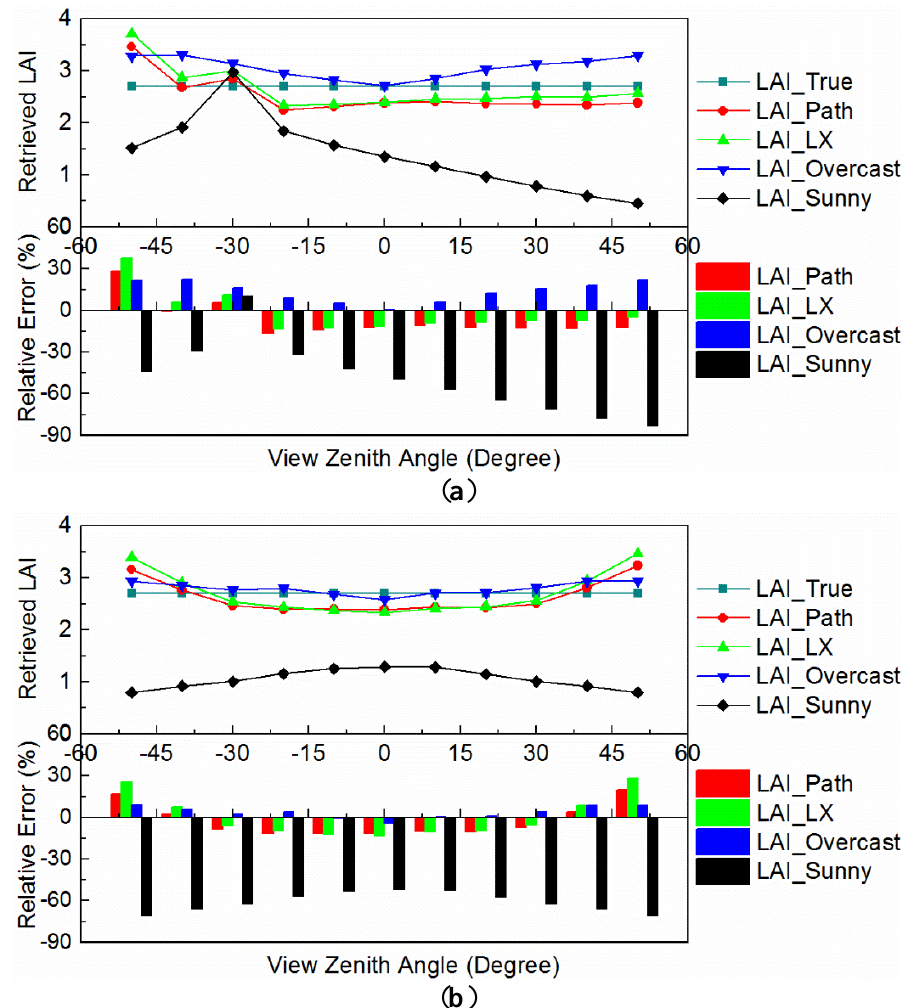
Figure 9. The retrieved LAI and the corresponding Relative Error (RE) by four different methods in the principal plane ( a ) and in the cross plane ( b ). The LAI_True is the true LAI set in the 3D realistic structural scene, which serves as the ground reference value; LAI_Path and LAI_LX are the retrieval of LAI by the sunlit foliage component under sunny conditions with the CI estimated by the path length-based method and the LX method, respectively; LAI_Overcast and LAI_Sunny are the retrieval of LAI by the directional gap fraction model under overcast conditions and under sunny conditions,